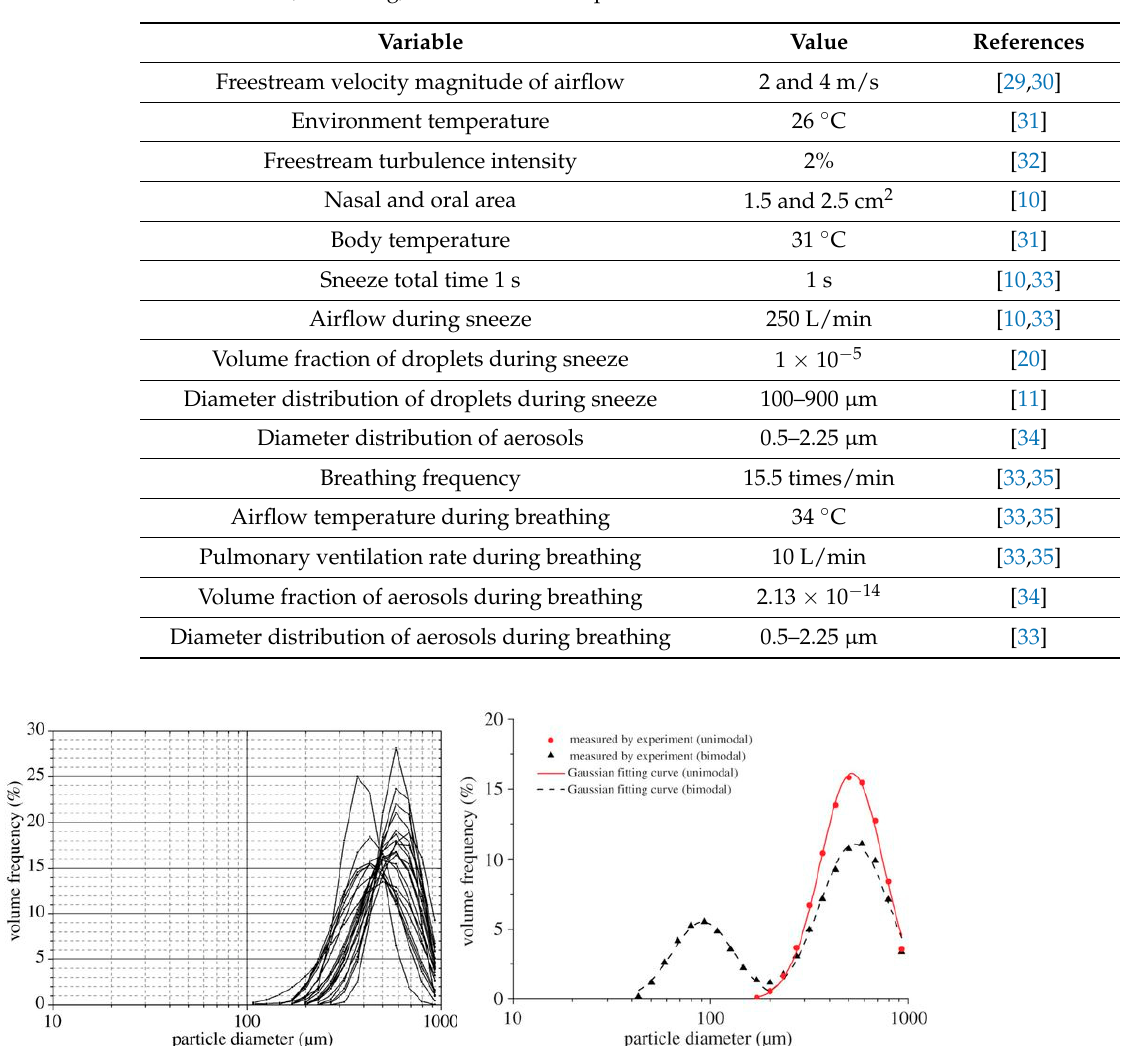
Table 1. Sneeze, breathing, and site condition parameters.